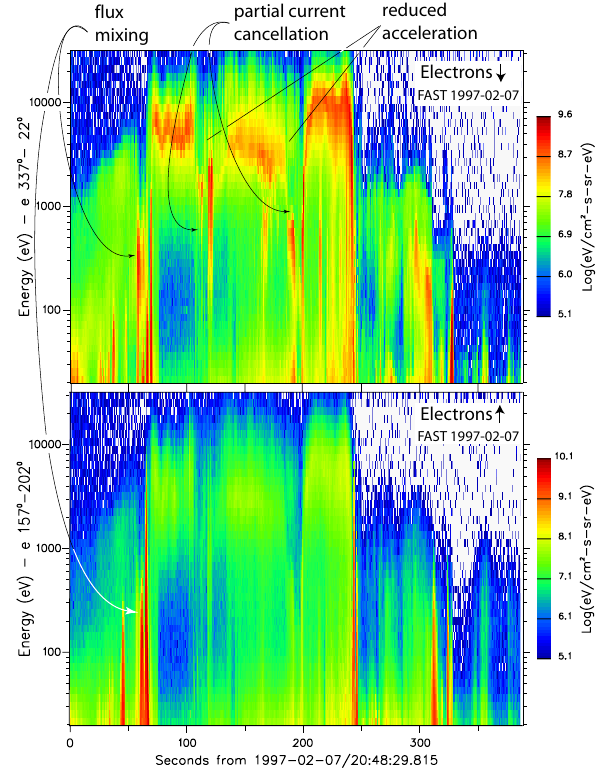
Fig. 1. A representative irregular sequence of (low temporal res- olution) auroral upward and downward electron fluxes (observed by Fast in the northern hemispherical auroral region) during active substorm aurorae. The upper panel shows the measured electron fluxes within an angle of ∼ 20 ◦ centred on the direction parallel to the geomagnetic field, the lower panel is centred on the direction anti-parallel to the geomagnetic field. Within the angular resolution of the instrument the asymmetry in the intensity of the data in both panels confirms the division of the auroral region into latitudinally adjacent regions dominated by either upward or downward electron fluxes corresponding to downward or upward field aligned currents, respectively. Note also the differences in electron energy. Upward electrons have low energies with maximum flux below 100eV, i.e. accelerated from ionospheric electrons, while downward electrons dominate at several keV energy, i.e. being of magnetospheric origin (figure taken from Treumann et al.,